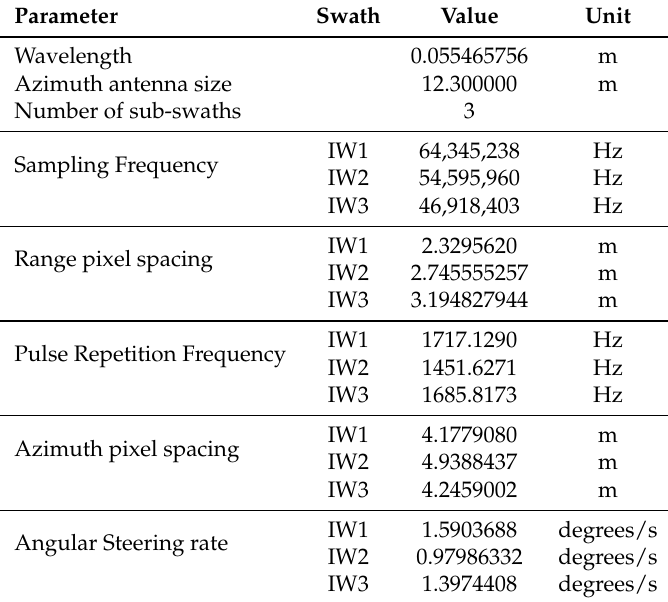
Table 2. Sentinel-1A/B raw data parameters